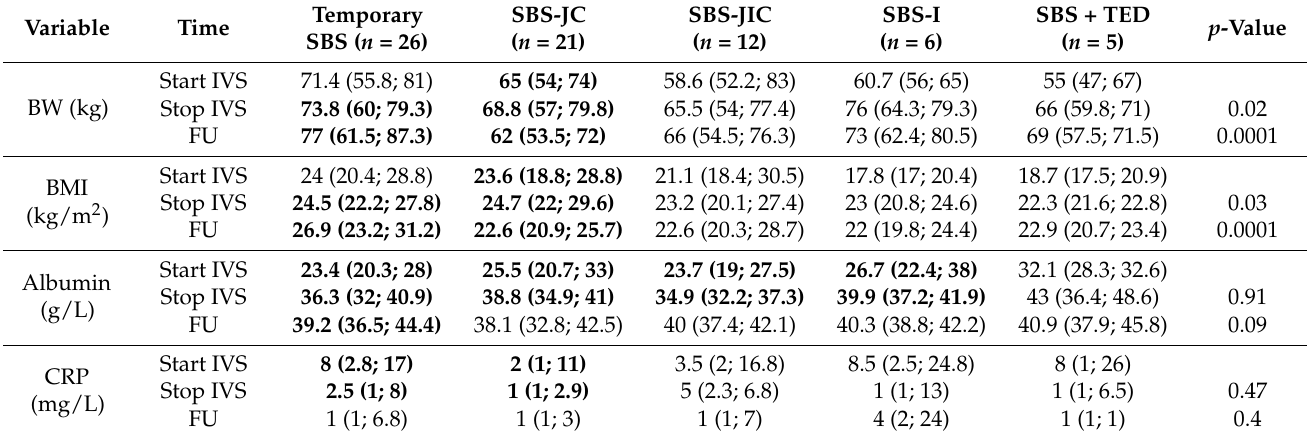
Table 3. Changes in nutritional markers during IVS and FU after